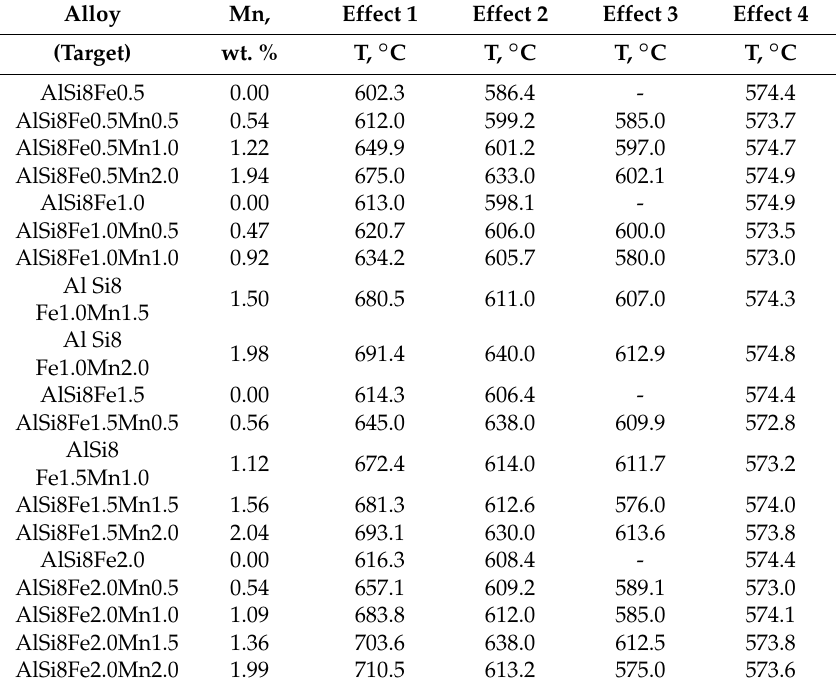
Figure 5. Cooling curve of the alloy AlSi8Fe2.0Mn1.0 from isopleth AlSi8Fe2–Mn. Table 4. Results of the evaluation of the cooling curve effects of the alloys from isopleths AlSi8Fe0.5–Mn, AlSi8Fe1–Mn, AlSi8Fe1.5–Mn, and AlSi8Fe2.0–Mn.